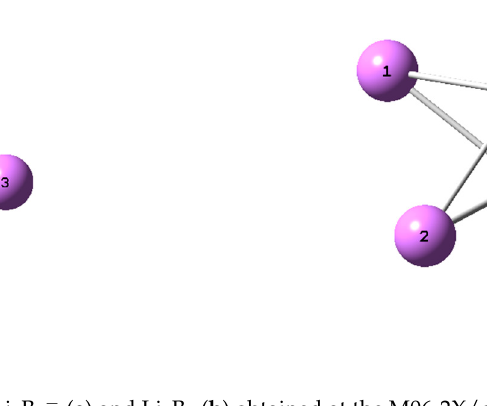
Dissociation Path